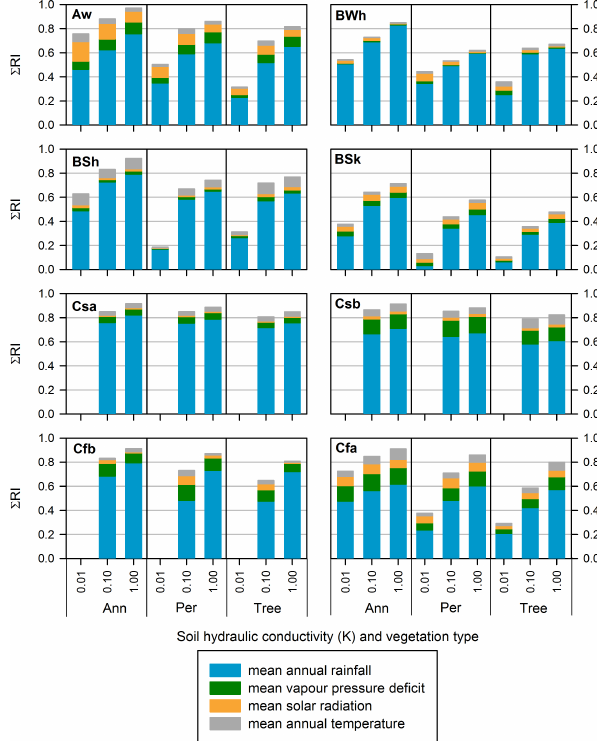
Fig. 3. Relative importance of climate characteristics ( P RI) for the considered climate types (see Fig. 1), under soil with selected hydraulic conductivities ( K = 0 . 01md − 1 , 0.1md − 1 or 1.0md − 1 ) and three vegetation types (Ann – annuals, Per – perennials and Trees); note that in Csa, Csb and Cfb zones, clay-rich soils ( K = 0 . 01md − 1 ) are not